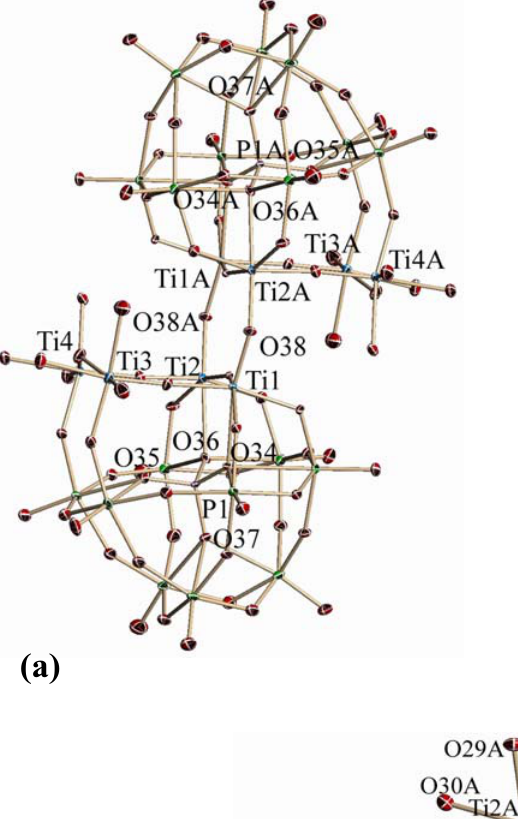
Figure 2. (a) Molecular structure of the dimeric polyoxoanion [[{Ti(H PW Ti O )] 26- ( 1 ) in K-1 , (b) its polyhedral representation, and (c) the partial structure 9 2 38 around the Ti center. In (b), the four octahedral groups (green) of the eight octahedral 8 TiO units are in the class of one host-two guest type coordination and the remaining four 6 octahedral groups (blue) are in the class of one host-one guest type coordination. The two intermolecular Ti-O-Ti bonds are formed between the octahedra (blue octahedra) of the one host-one guest coordination. All 18 WO central PO groups are shown in yellow. Total 12 coordinated water molecules are 4 exhibited as open circles in the terminal positions in the four TiO